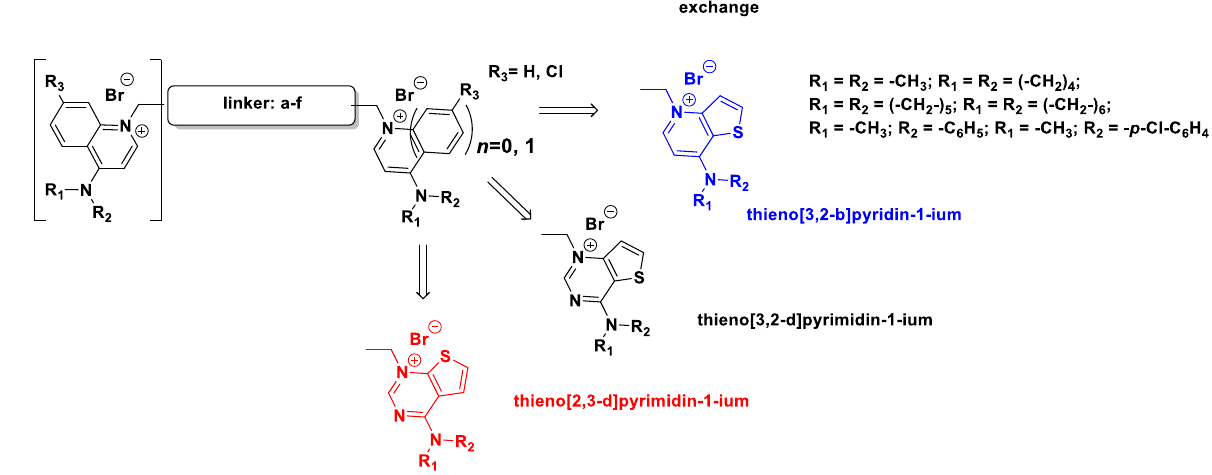
Figure 1. General structure of the final compounds .